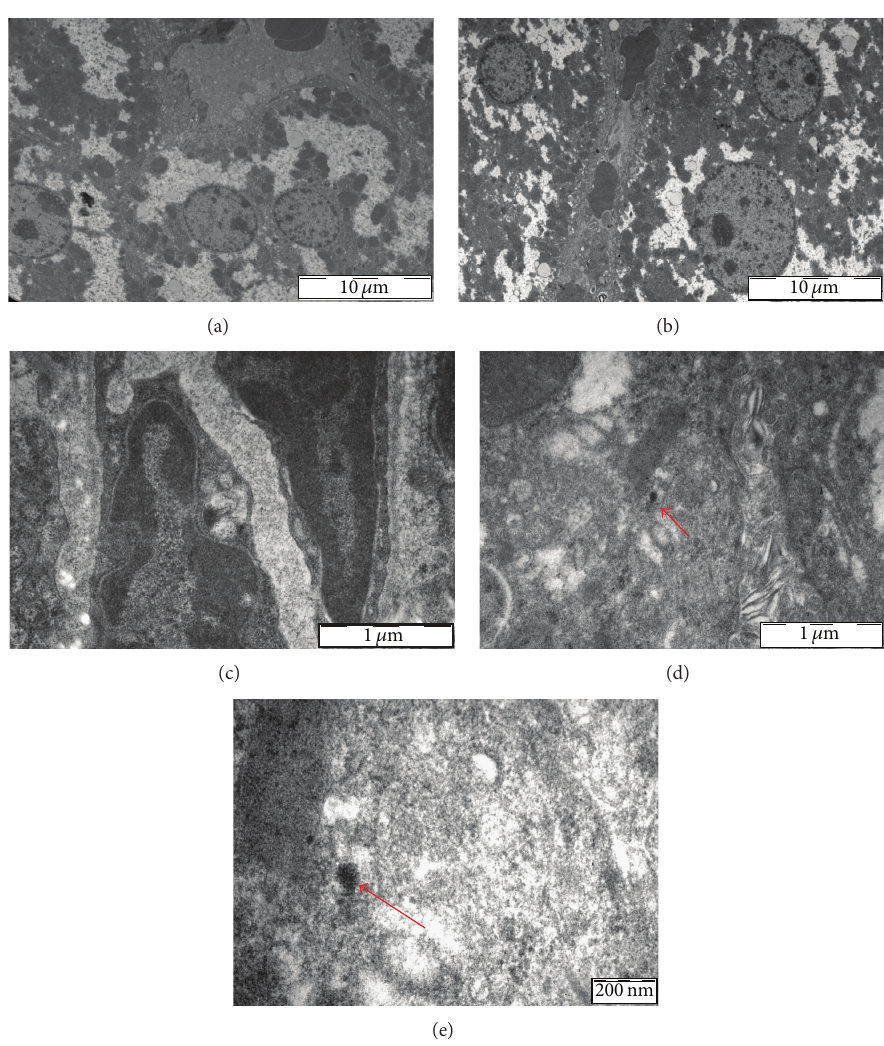
Figure 1: Electron micrographs of liver ultrathin sections of negative controls ((a), 3400x, (c), 34000x) and treated mice ((b) 3400x, (d) 34000x, (e) 92000x). In liver sections from treated animals it is possible to observe (arrows) the presence of nanoparticle agglomerates (inside Kupffer